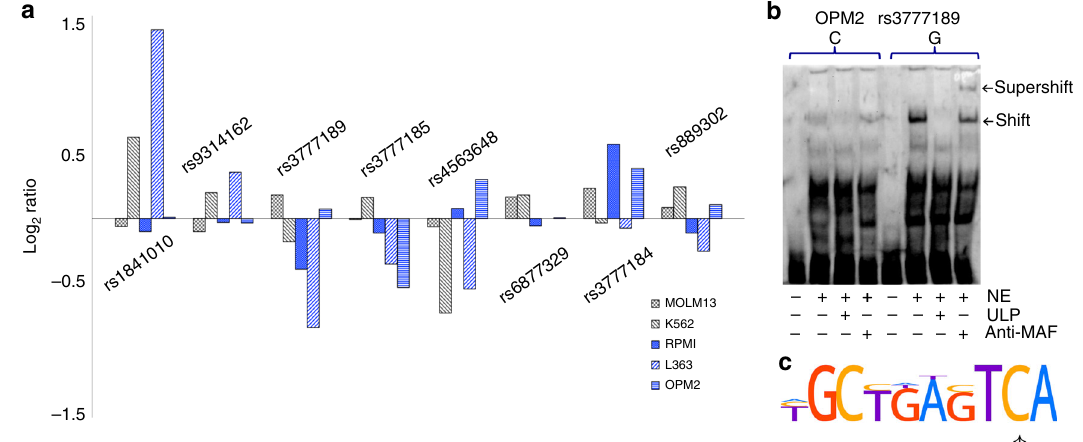
Fig. 3 Identi fi cation of causal variants. a We evaluated eight variants located in regulatory regions of ELL2 (Fig. 2c and Supplementary Table 1) using luciferase assays in RPMI-8226, OPM2, and L363 plasmocytoma lines, and in K562 and MOLM-13 cells that represent other hematologic lineages. Consistent with the effect on ELL2 expression in plasma cells but not in peripheral blood, three risk variants (rs3777189-C, rs3777185-C, and rs4563648- G) yielded reduced activity in the plasma cell lines but not in the control cell lines, whereas the remaining variants showed opposite or inconsistent effects. Plotted values represent log 2 -ratios of luciferase activities for the risk alleles over their corresponding protective alleles (median over tri or quadruplicates). b To identify the responsible transcription factors, we carried out sequence analyses and electrophoretic mobility shift assays (EMSA) (Supplementary Figs. 5 and 6). Shown here is EMSA with nuclear extract (NE) from OPM2 cells (lanes 2 – 4 and 6 – 8), and probes representing genomic sequence at rs3777189 with the risk/low-expressing allele (C) or the protective/high-expressing allele (G) in the center (lanes 1 – 4 and 5 – 8, respectively). The G allele showed an allele-speci fi c shift (lane 6) that was outcompeted with unlabeled probe (ULP; lane 7) and supershifted with MAFF/G/K antibody (lane 8). Similar results were seen with L363 cells (Supplementary Fig. 5). c Sequence analysis predicted loss of a MAFF/G/K motif (Supplementary Table 4). Shown here is the MAFK motif from the HOCOMOCO-10 database. Arrow indicates G changed to C by the rs3777189-C risk variant